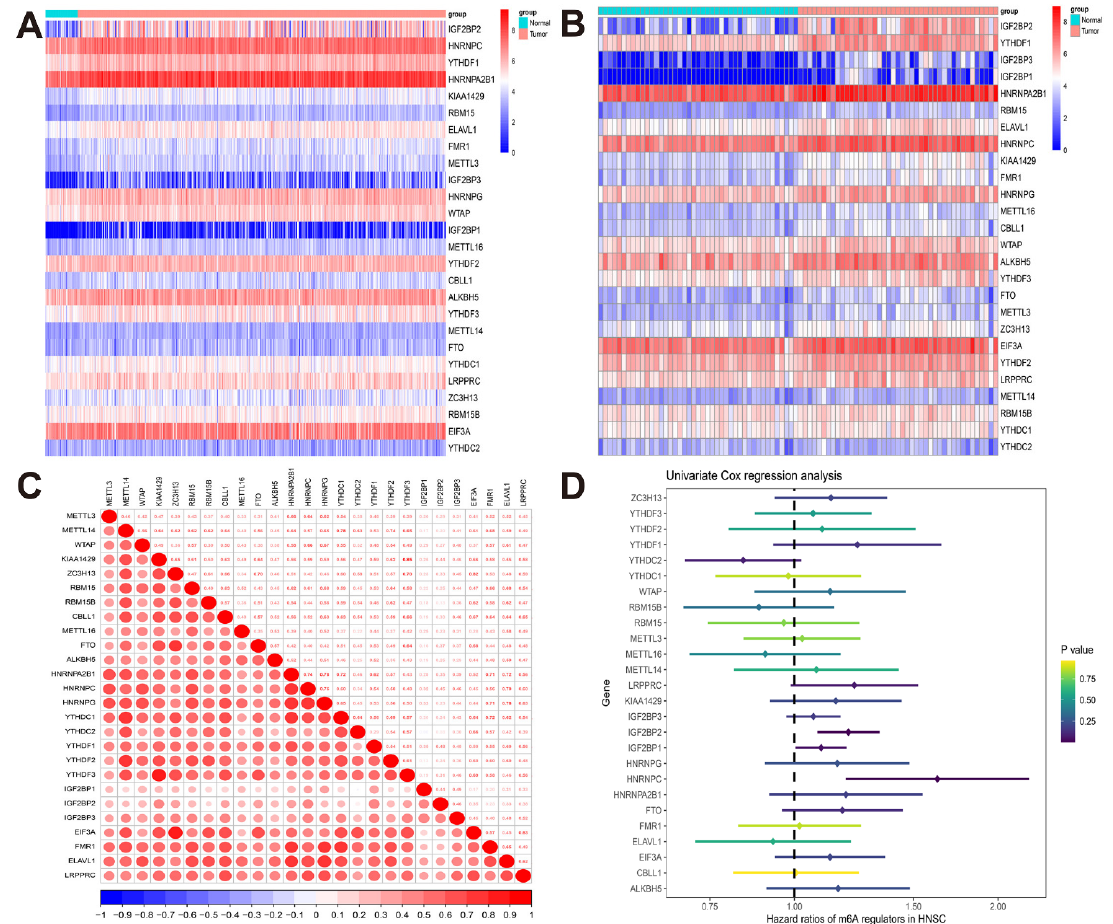
Figure 1. The landscape of m 6 A regulators in TCGA-HNSCC cohort. ( A ) Heatmap showing the expressions of m 6 A regulators between 44 normal and 502 tumor tissues; ( B ) heatmap showing the expressions of m6A regulators between 43 tumors and paired normal tissues; ( C ) the correlation between the m 6 A regulators in the TCGA-HNSCC cohort; ( D ) forest plot of univariate Cox regression analysis of m 6 A regulators associated with